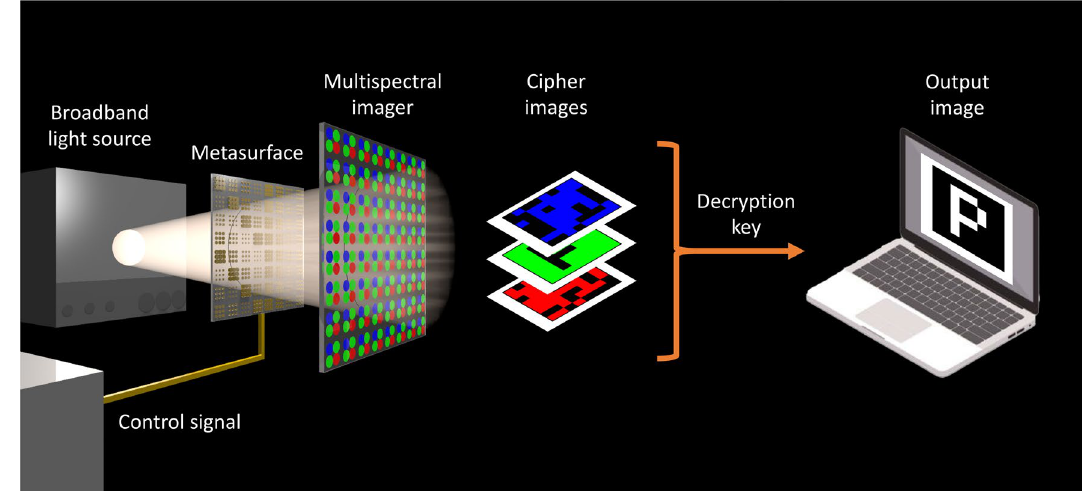
Figure 1. Potential implementation of our encryption scheme. A controllable metasurface (or alternatively, a spatial-light modulator or dynamic hologram) is used to imprint spatial and spectral information onto a broadband light source. To decrypt the image, a recipient must use a multispectral imager to record individual wavelength channels, or cipher images and apply a decryption key. A CMOS array will, for example, provide three channels (RGB), while advanced multispectral or hyperspectral imagers can increase the number of channels to 128 43 .